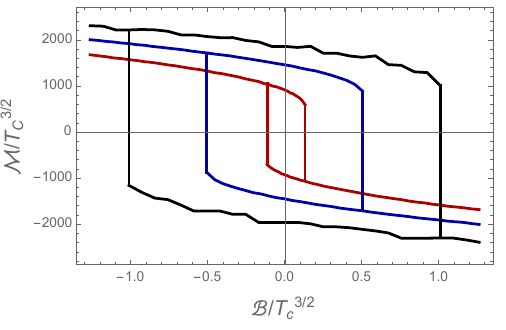
Figure 5 . Temperature dependence of the hysteresis curve with T=T C = 0.98 (red), 0.96 (blue), 0.93